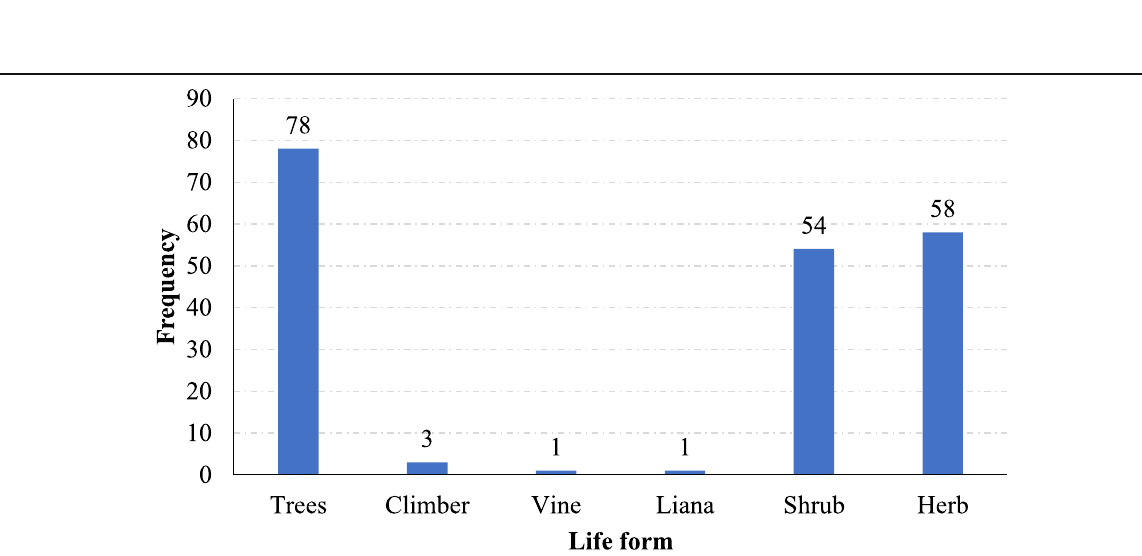
Fig. 3 Growth habit of the plants used for preparation of antitubercular remedies in East